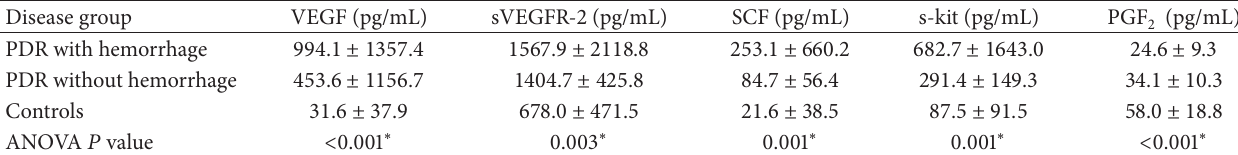
Table 3: Comparisons of mean angiogenic and vasculogenic factor levels in proliferative diabetic retinopathy (PDR) patients with or without